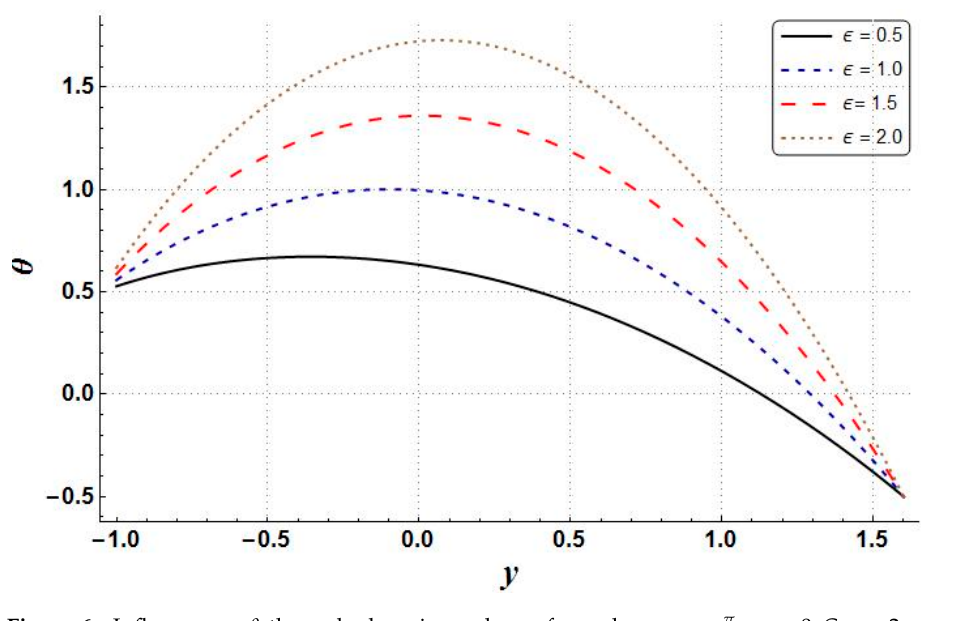
, x = 0, Gr = 2, α = π 4 ∈ , where